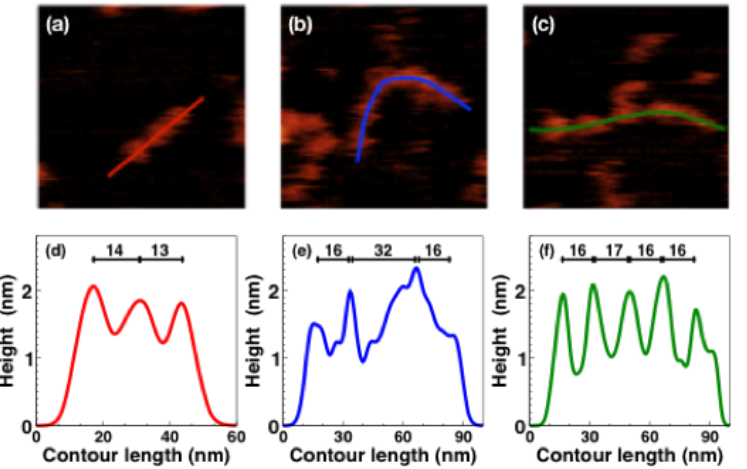
Figure 3. ( a – c ): Zoom of three regions of 100 nm × 100 nm size, selected from dashed squares in Figure 1. The elongation axis, or contour profile, of polymers is marked with colored solid curves. ( d – f ): height profiles along the contour length of polymers displayed in ( a – c ) respectively. The solid bars within each panel report the pitches between two peaks in the height profile; the numbers above each bar are the length in